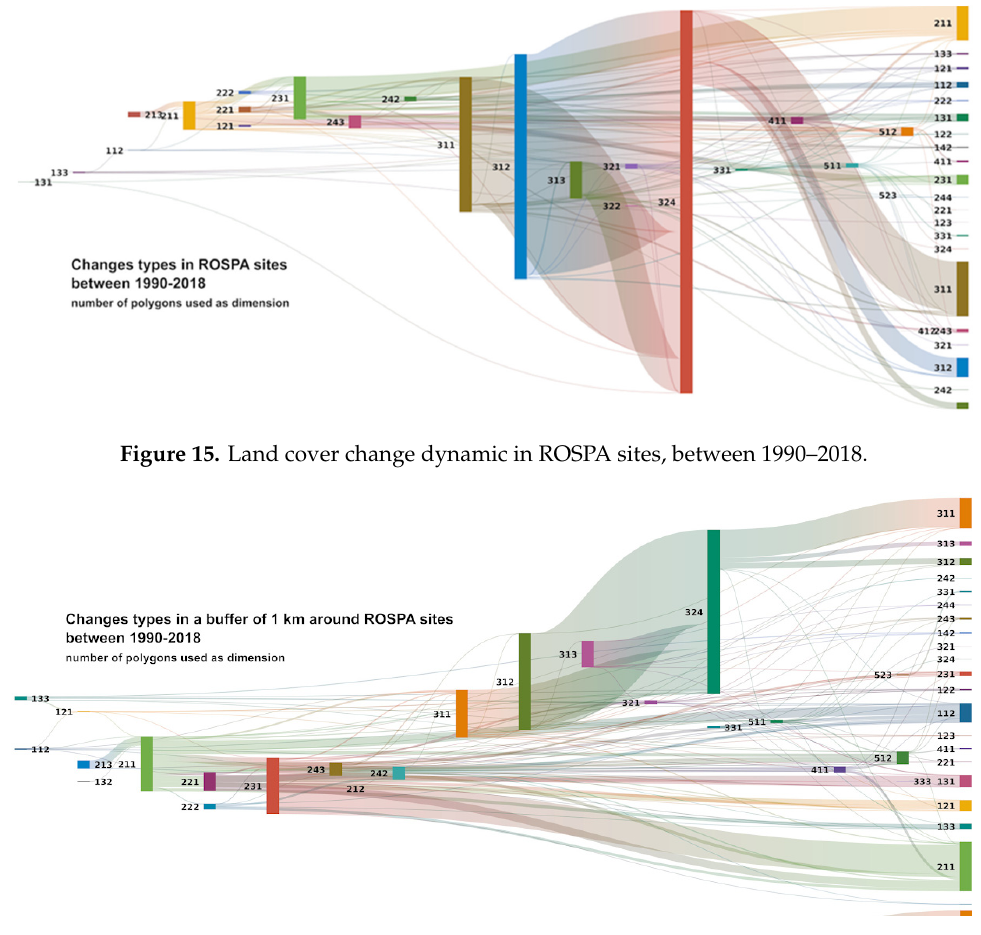
Figure 16. Land cover change dynamic in buffer of ROSPA sites, between 1990–2018.